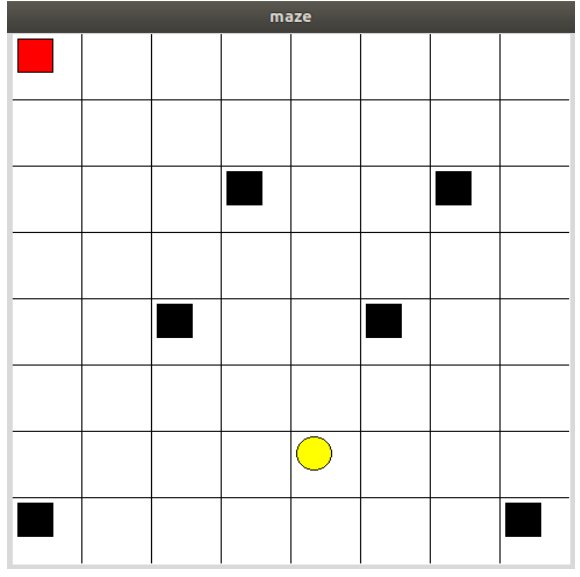
Figure 1. Maze Environmental